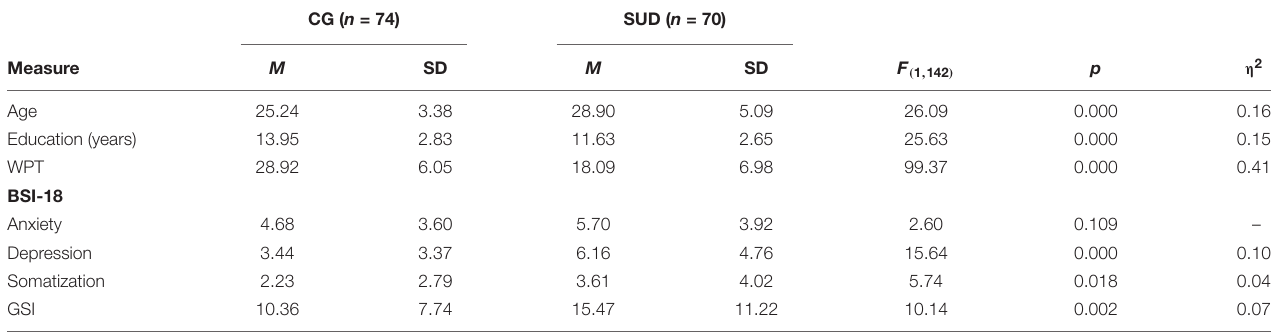
TABLE 2 | Group differences (ANOVA) in demographic data, cognitive ability, and psychiatric symptoms.